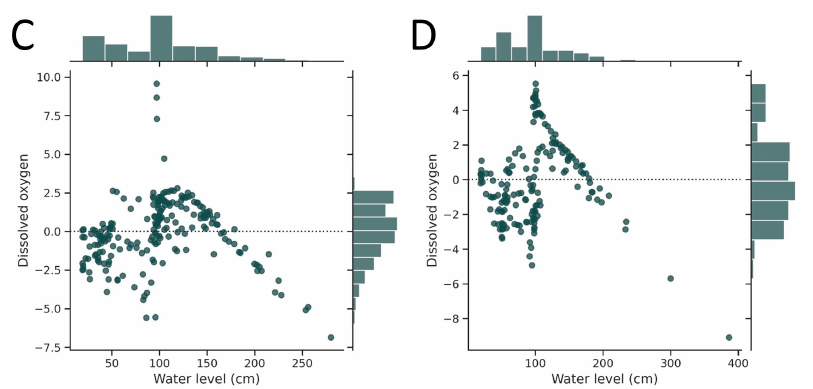
Figure 9. ( A , B ) Regression plot of water level and DO of the Pivka River and ( C , D ) residual plot in 2017 and 2021, respectively.